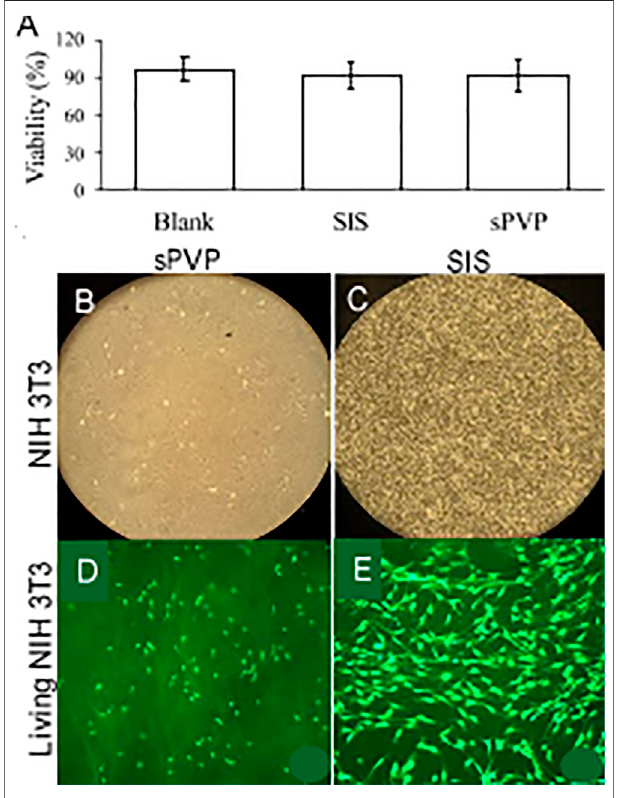
FIGURE 4 | In vitro cytotoxicity of sPVP in comparison with SIS. (A) Cellular viability (%). (B – C) NIH 3T3 cells on sPVP and SIS, respectively. Objective: ×4. (D – E) Calcein marked (green) NIH 3T3 cells on the PVP and SIS, respectively. Objective: ×60.